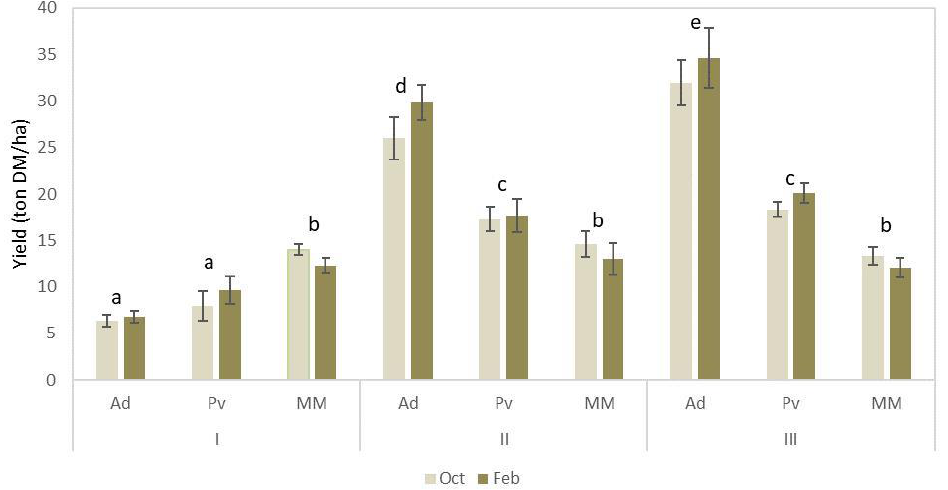
Figure 2. Estimated biomass yield of the treatments, each column representing each harvest operation under the different combination of year (I, II and III), species (Arundo—Ad, switchgrass—Pv and mixed meadows—MM) and harvest times (October and February). Error bars represent SD and letters a, b and c label statistically homogeneous subgroups ( p < 0.05).